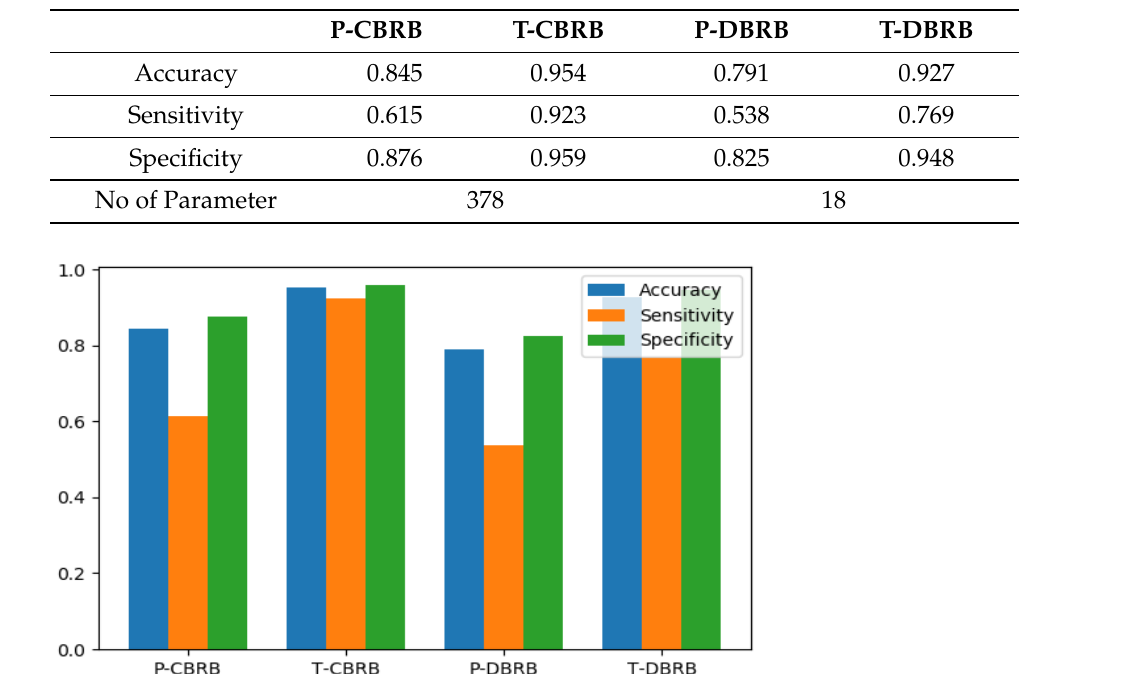
Table 10. Comparision among different BRB models.